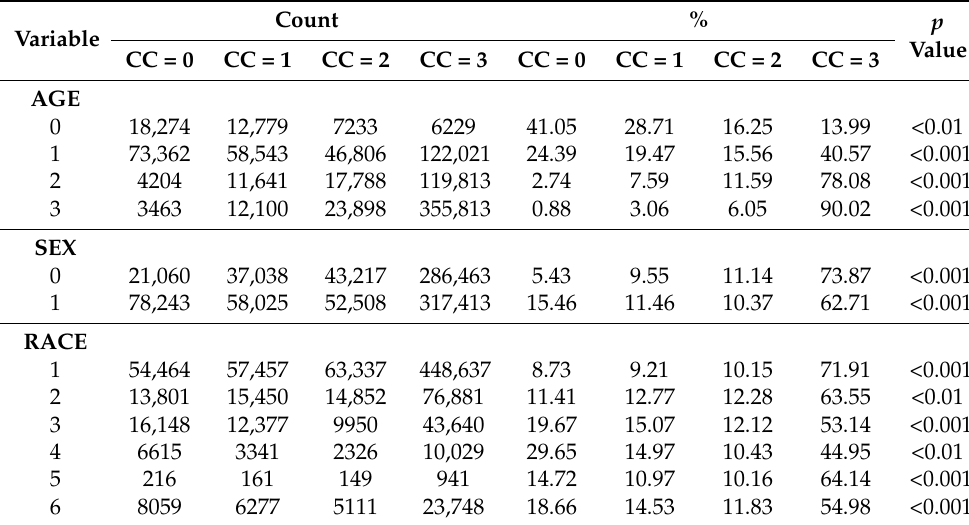
Table 3. Differences in characteristics of patients among CC. Chi-square test is used to calculate p values for differences across CC’s categories.